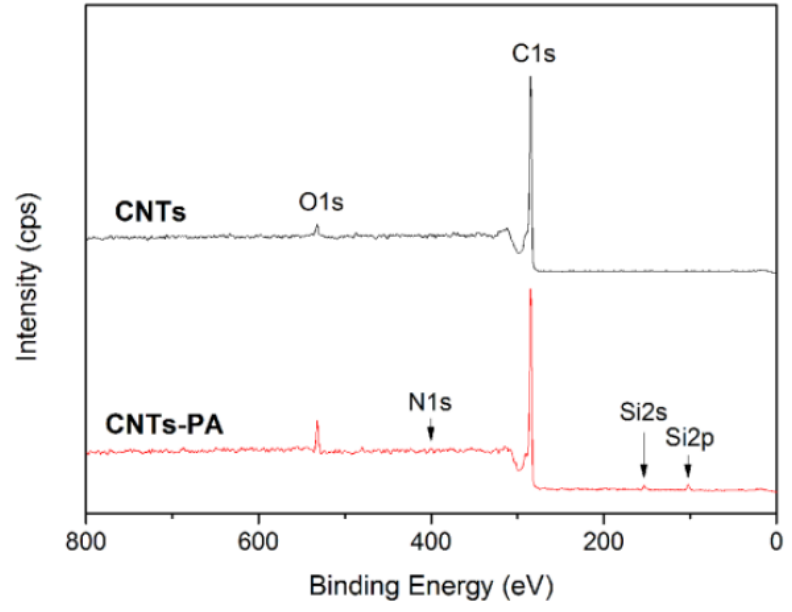
Figure 3. XPS survey spectra of CNTs and Figure 3 . XPS survey spectra of CNTs and CNTs ‐ PA. Table 1 . Element composition of CNTs and CNTs ‐ PA.